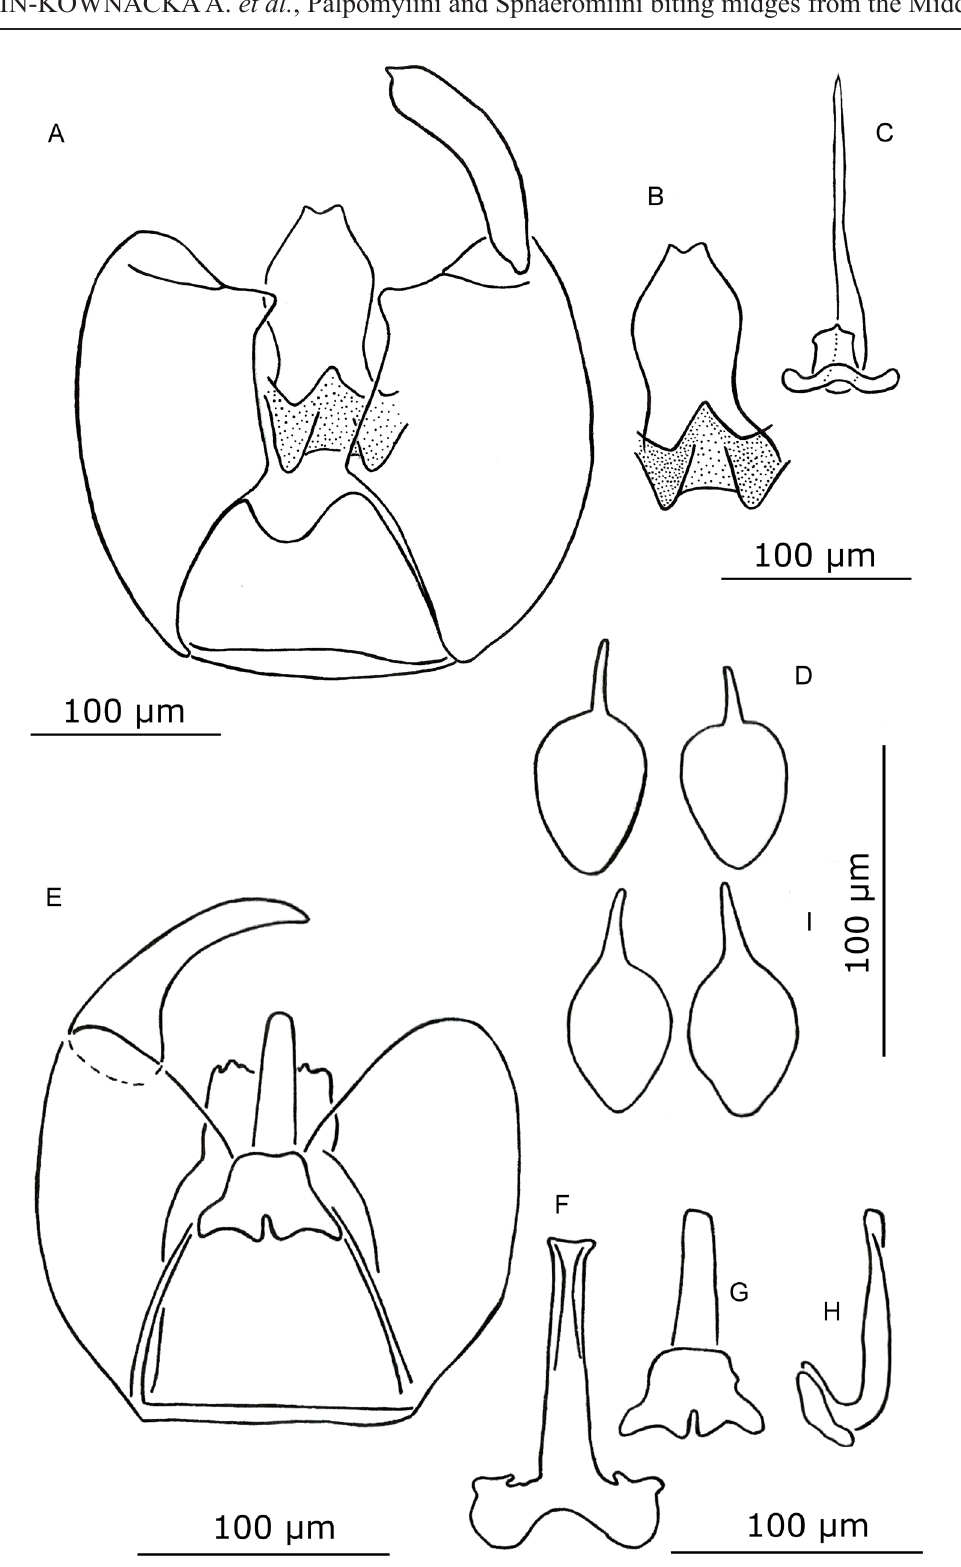
Fig. 3. Bezzia ( Sivabezzia ) spp. A–D . Bezzia pachypyga , ♂ (from Remm 1974). A . Genitalia, ♂. B . Parameres. C . Aedeagus. D . Seminal capsules, ♀. – E–I . Bezzia melanoflava (from Clastrier 1958). E . Genitalia, ♂. F . Parameres. G . Aedeagus, ventral view. H . Aedeagus, lateral view. I . Seminal cap- sules,